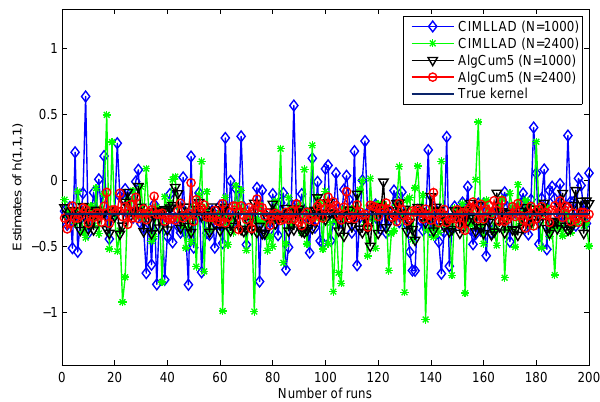
Figure 9. Estimated cubic kernel, h ( 1,1,1 ) = − 0.25, for system II.